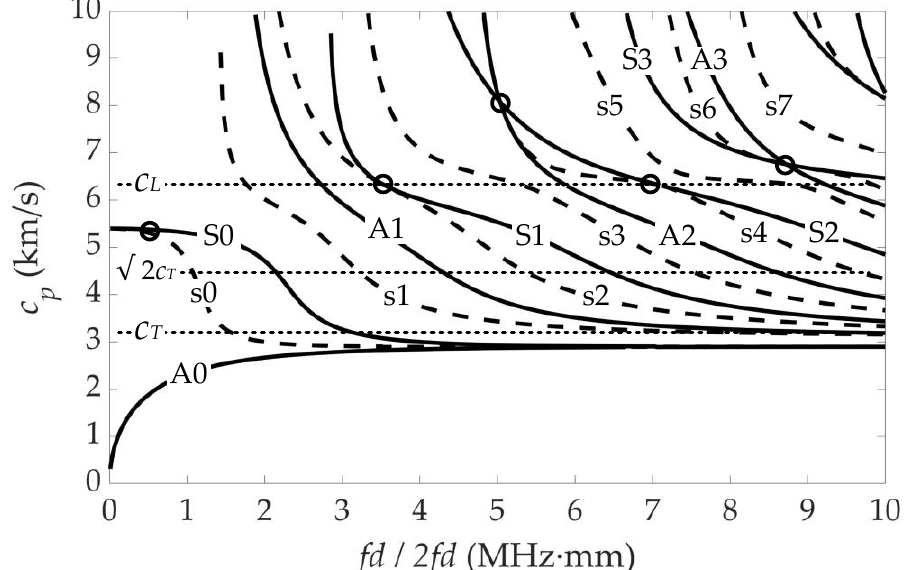
Figure 2. Internal resonance points of RL primary and secondary modes. The primary modes are shown as solid lines and plotted as fd . The secondary modes are shown as dash lines and plotted as 2 fd .